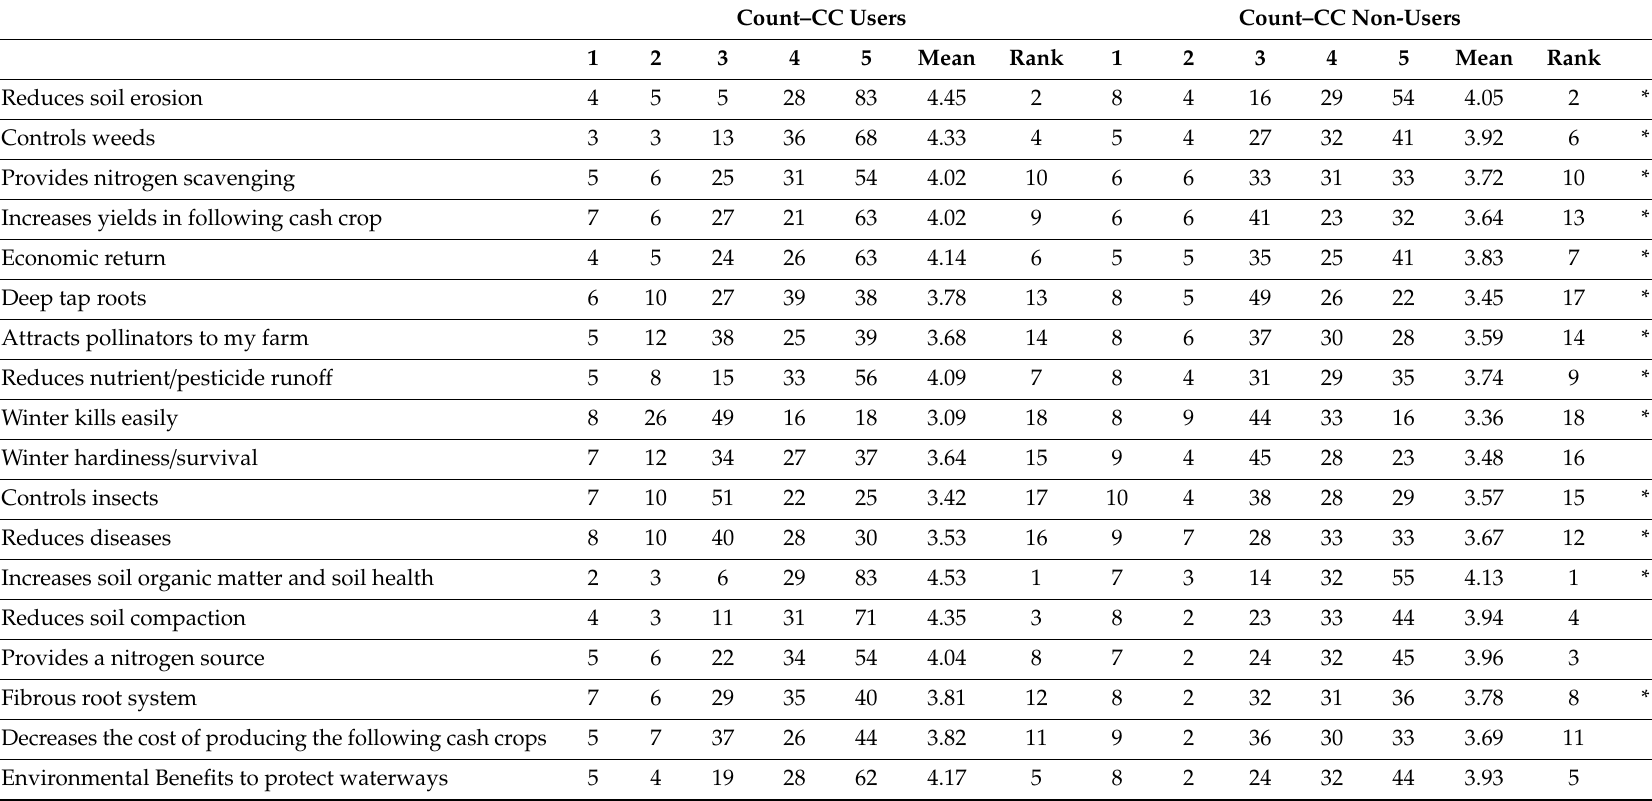
Table 2. Selected benefits associated with planting cover crops; means compared between cover crop users and